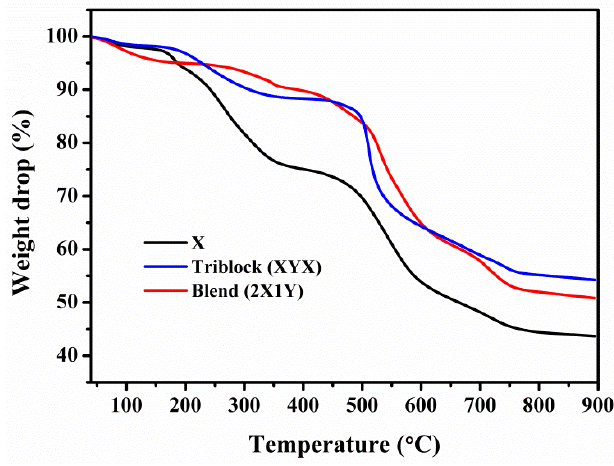
Figure 7. TGA curves of X, blend and block copolymer membranes.